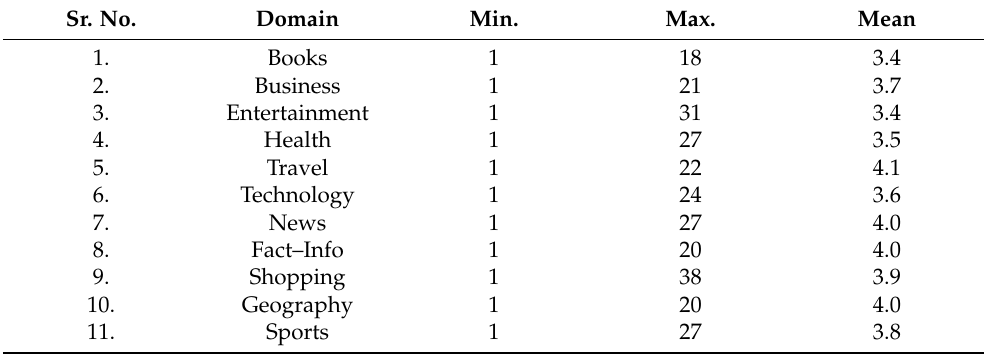
Table 3. Minimum, maximum and mean query length with respect to query domains. Sr. No.